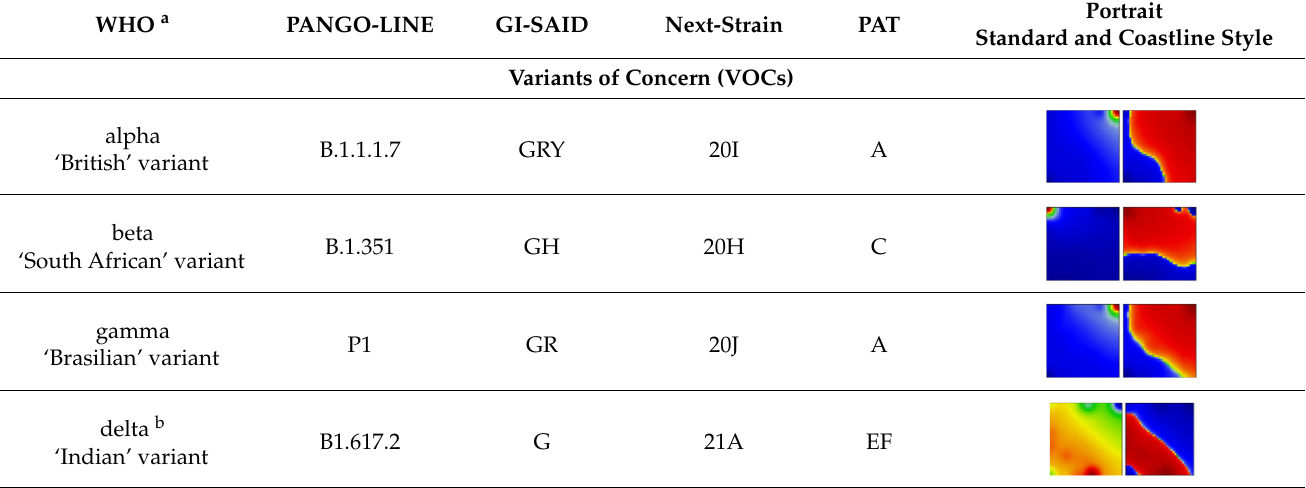
Table A1. SARS-CoV-2 labeling schemes a and gallery of the respective SOM-portraits.